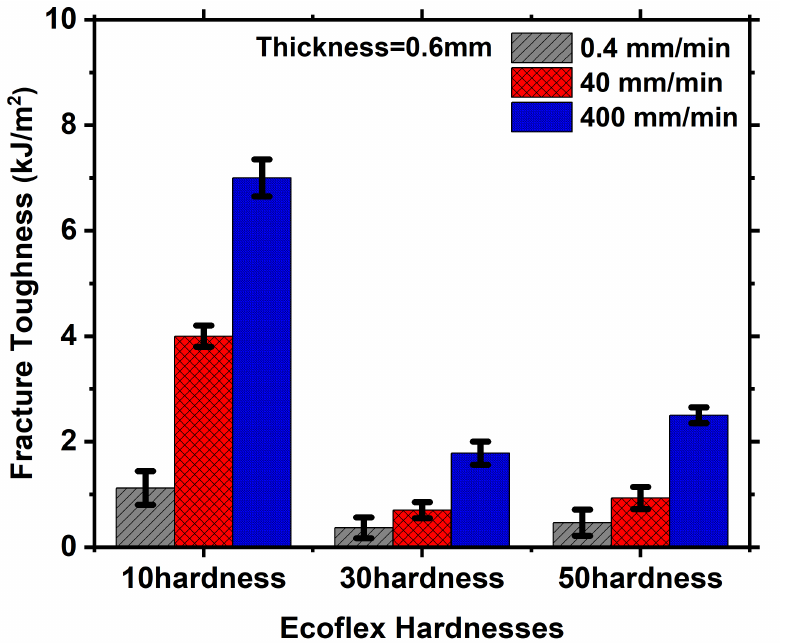
Figure 10. Bar diagram to represent the fracture toughness for different strain